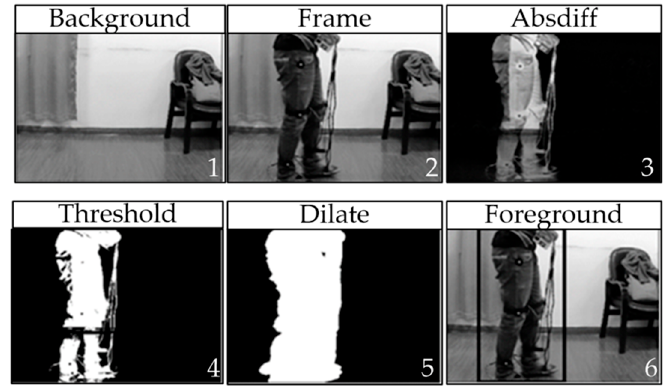
Figure 5. Foreground segmentation process.